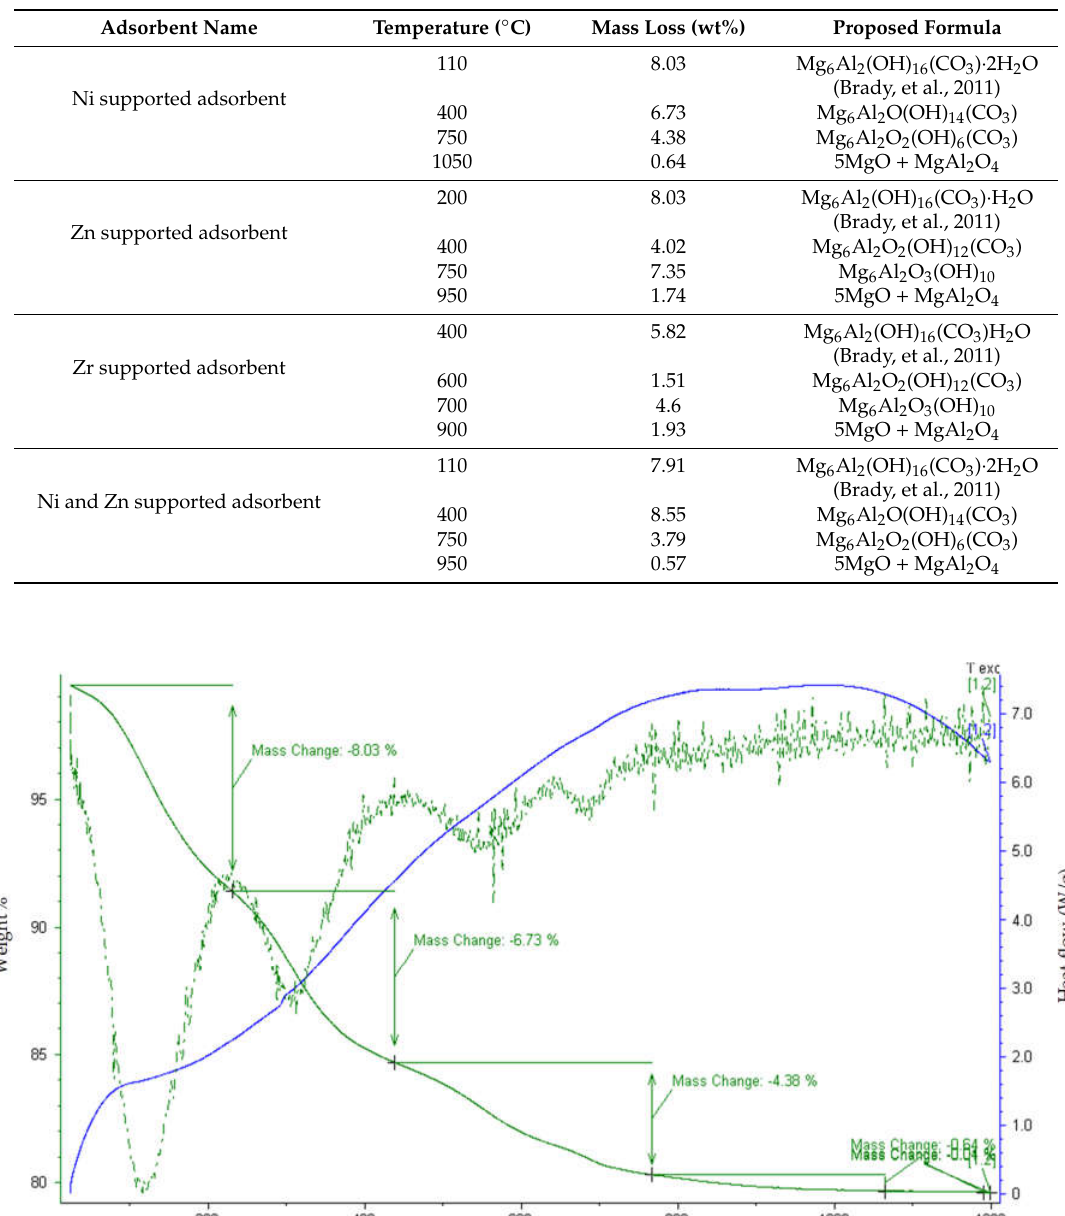
Table 3. Mass loss step for calcined five adsorbents.